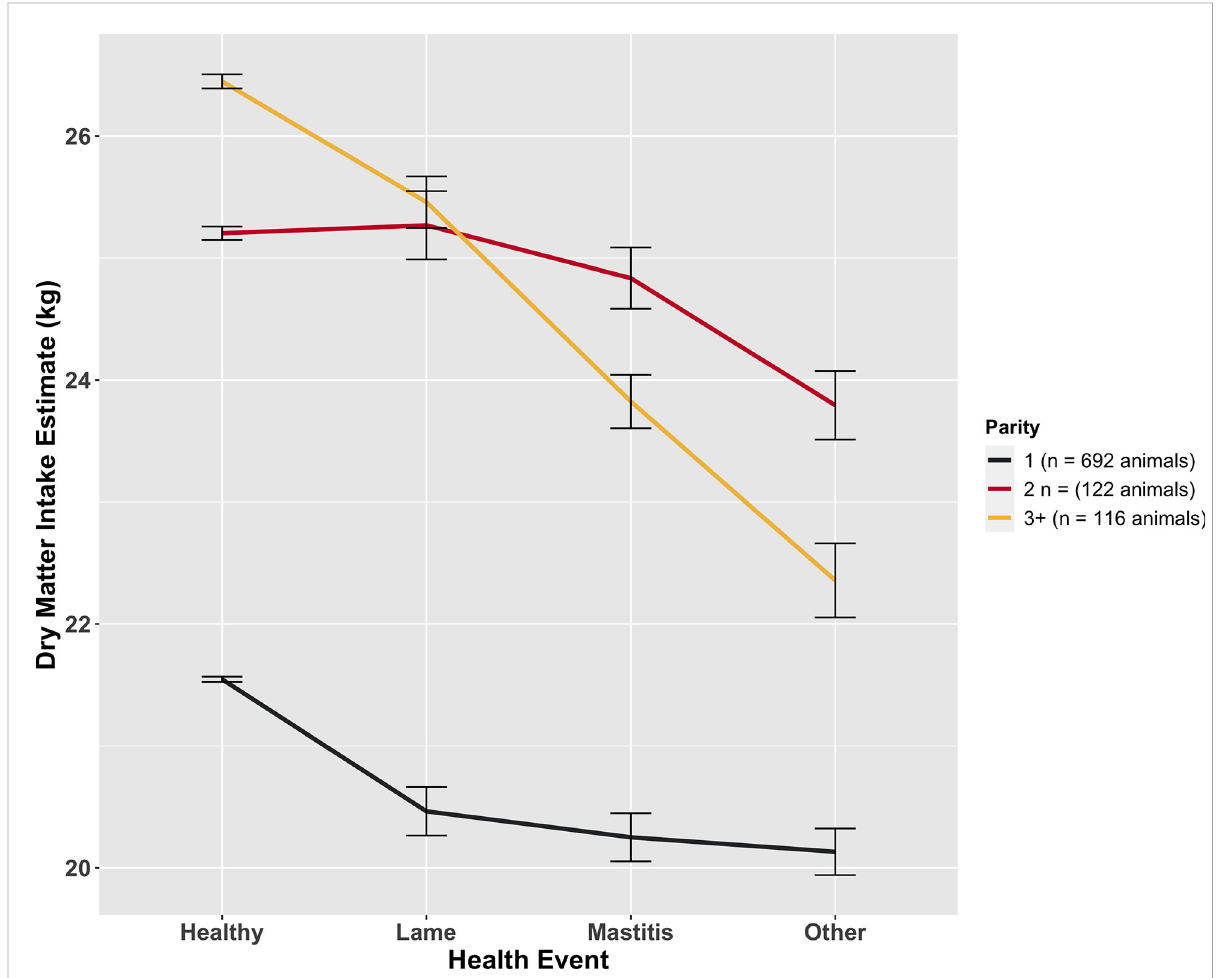
FIGURE 3 Impact of parity on dry matter intake (DMI) under different health disorders. Least squares means estimates of DMI for the interaction of health disorders and parity. The number of observations for each health category for parities 1, 2, and 3+ (P1, P2, P3+) are as follows: Healthy: 33,761 P1, 5,165 P2, 4,100 P3+; Lame: 289 P1, 146 P2, 262 P3+; Mastitis: 295 P1, 182 P2, 240 P3+; Other: 314 P1, 145 P2, 124 P3+. The other category included disorders with minimal observations, including respiratory illness, injury, and multiple concurrent health